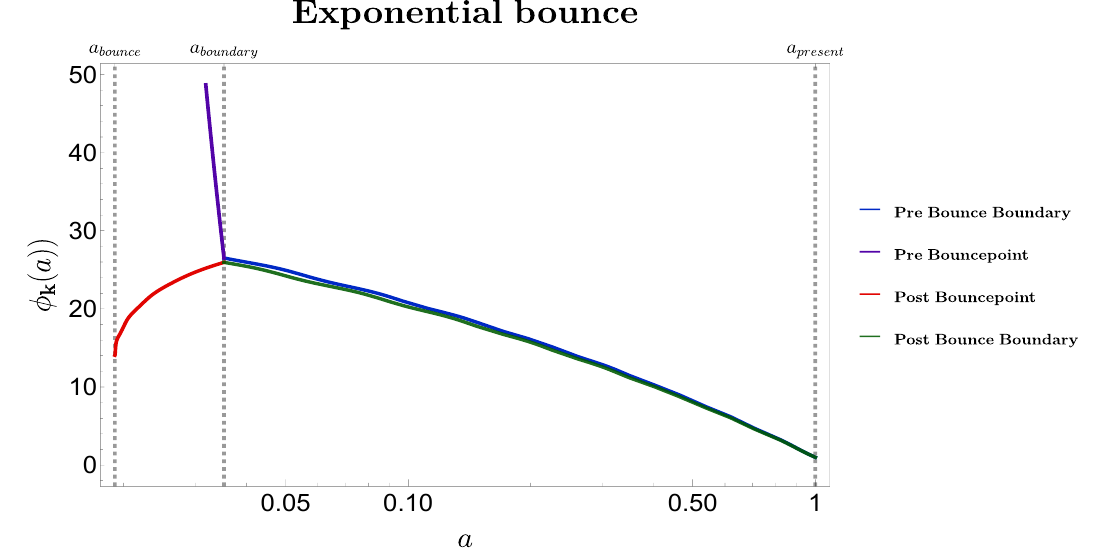
Figure 27: Squeezing angle at different regions plotted against scale factor.